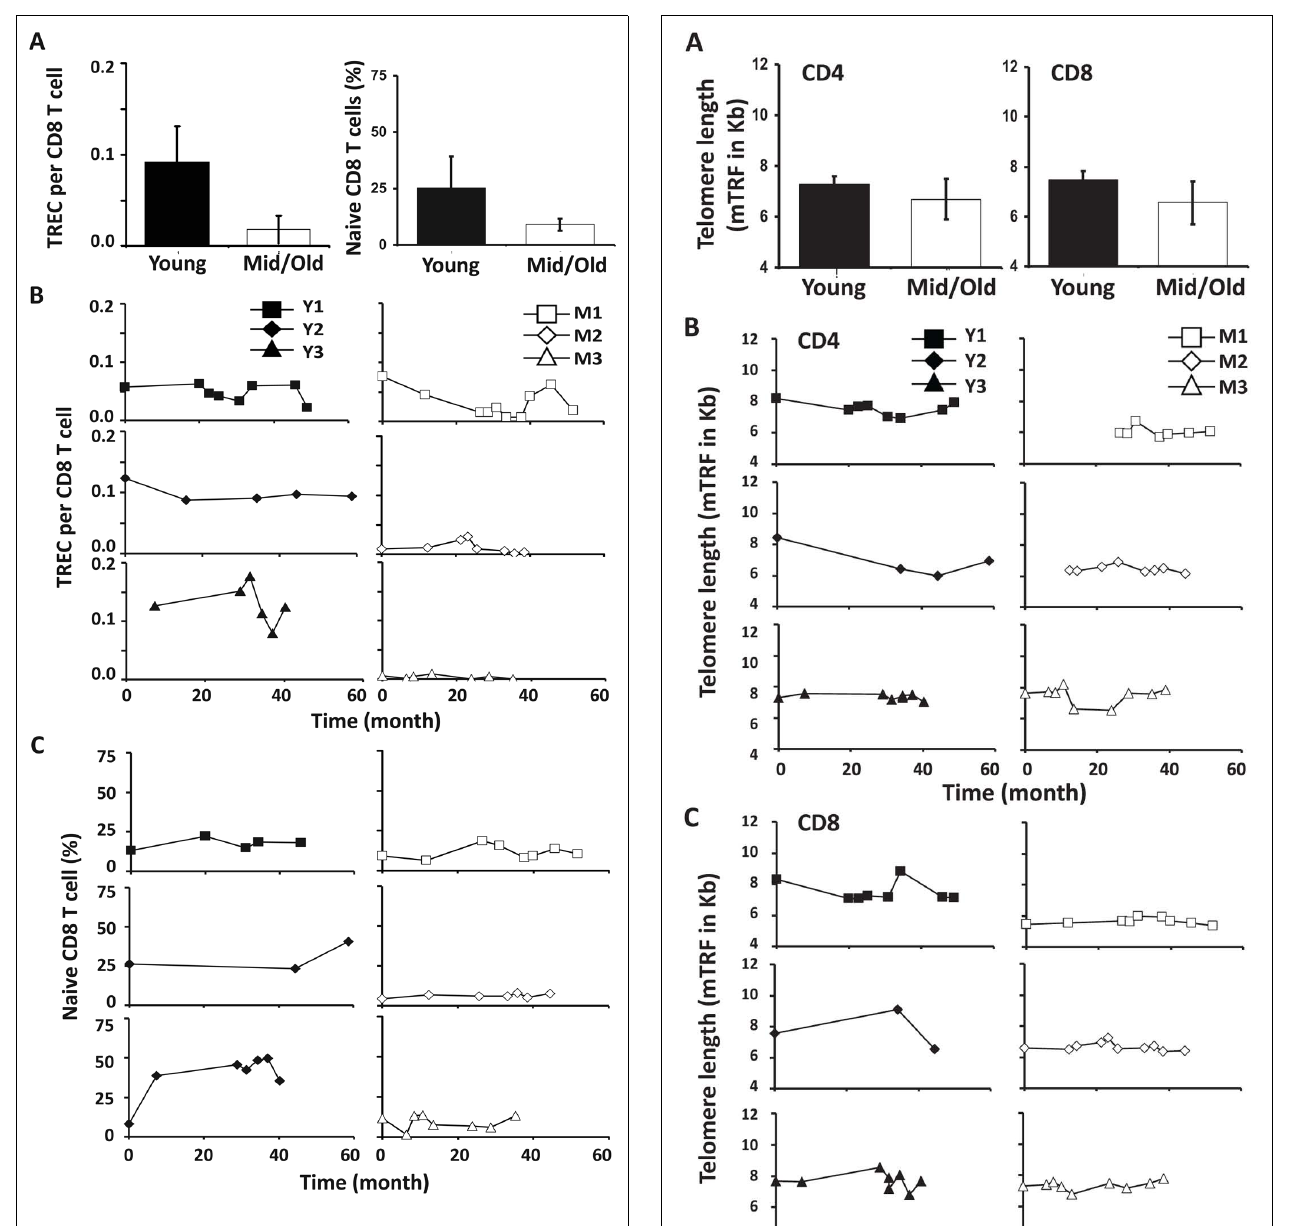
higher in young donors and lower in the middle-aged